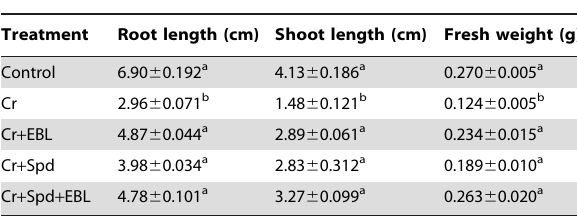
Table 1. Effect of EBL and/or Spd on morphological parameters of radish seedlings under